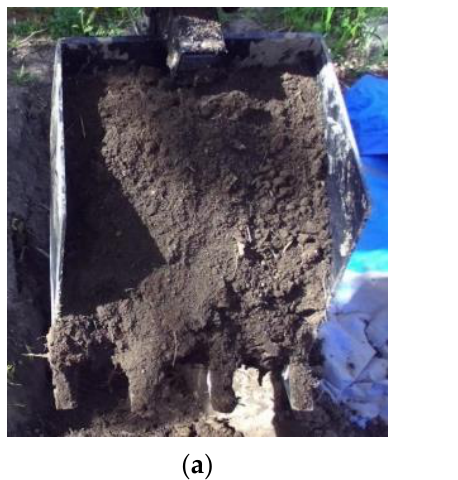
Figure 13. Merging the point cloud for the filled bucket soil volume into one for the CAD Model.